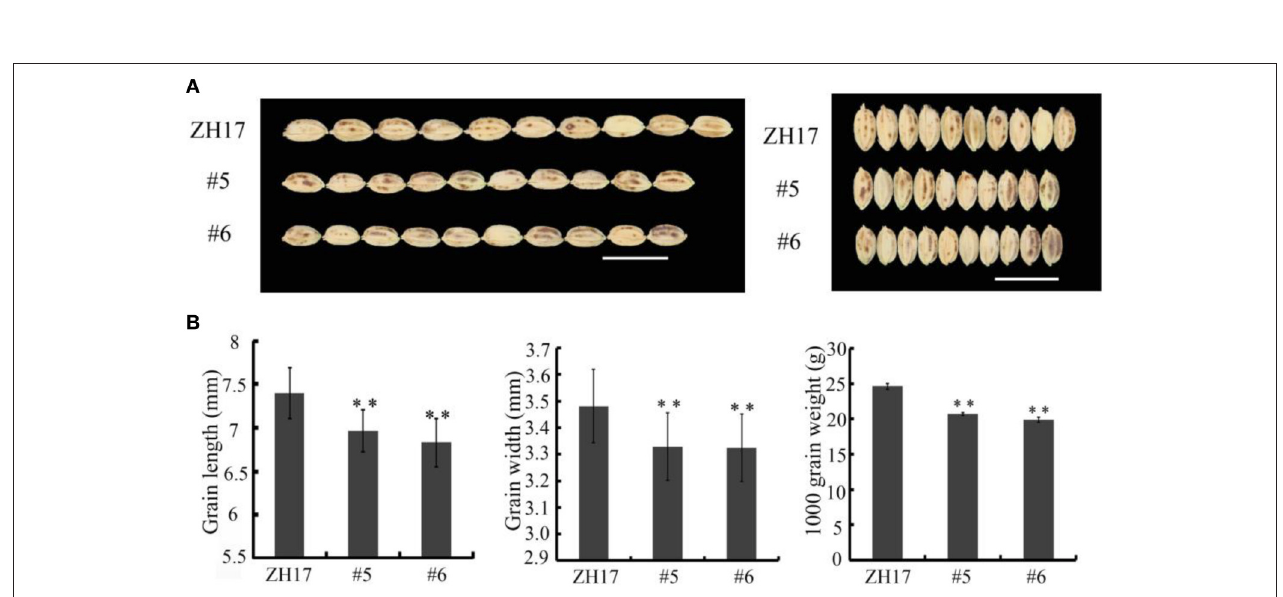
FIGURE 6 | Overexpression of OsCEP6.1 decreases grain size in rice. (A) Phenotypic variation between the control and OsCEP6.1 transgenic line in both gain length and width. (B) Constitutive expression of OsCEP6.1 significantly decreased seed length, seed width and 1000- grain weight, with 7, 4, and 19% reduction, respectively. Bar = 1cm. The values are means ± SD ( n ≥ 90 ), ** P < 0.01 .